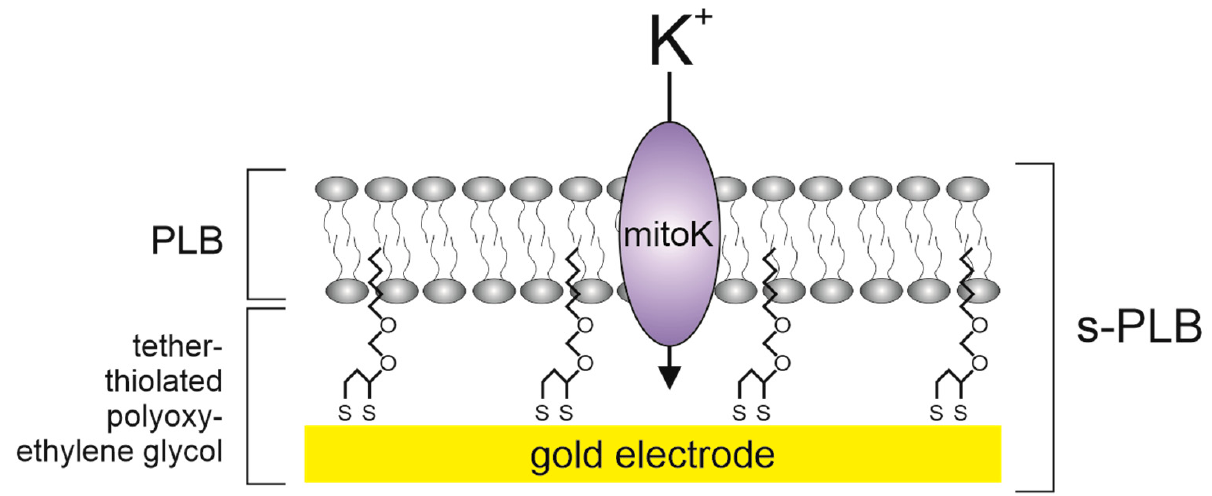
Figure 5. Solid supported membranes. Schematic drawing of the solid planar lipid bilayer s-PLB, showing the following parts: hydrophilic tether (e.g., thiol-derivatized polyoxyethylene glycol), providing covalent binding to the surface of gold, as well as an aqueous layer—a cushion—between the PLB and electrode; mitoK—potassium channel from the inner mitochondrial membrane; PLB— planar lipid bilayer. Please note that this scheme shows only one of the numerous possibilities of s- PLB deposition onto gold electrodes.